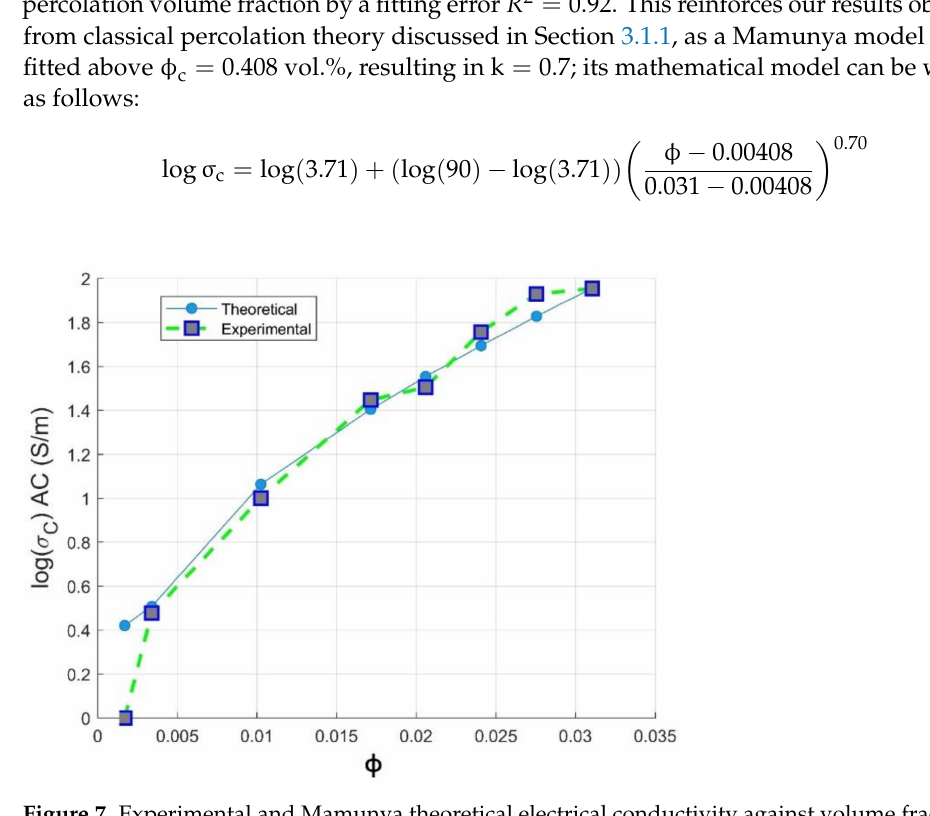
Figure 7. Experimental and Mamunya theoretical electrical conductivity against volume fraction of CNTs